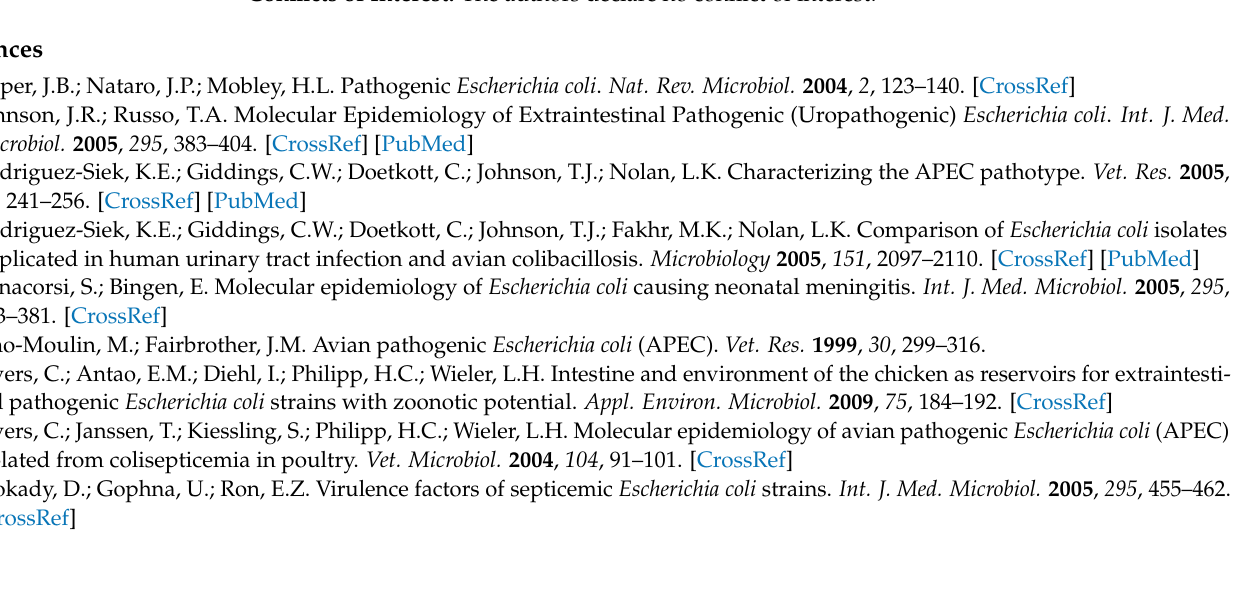
growth rate lysogeny broth. Figure S2: Results of plasmid control. Figure S3: Results of plasmid